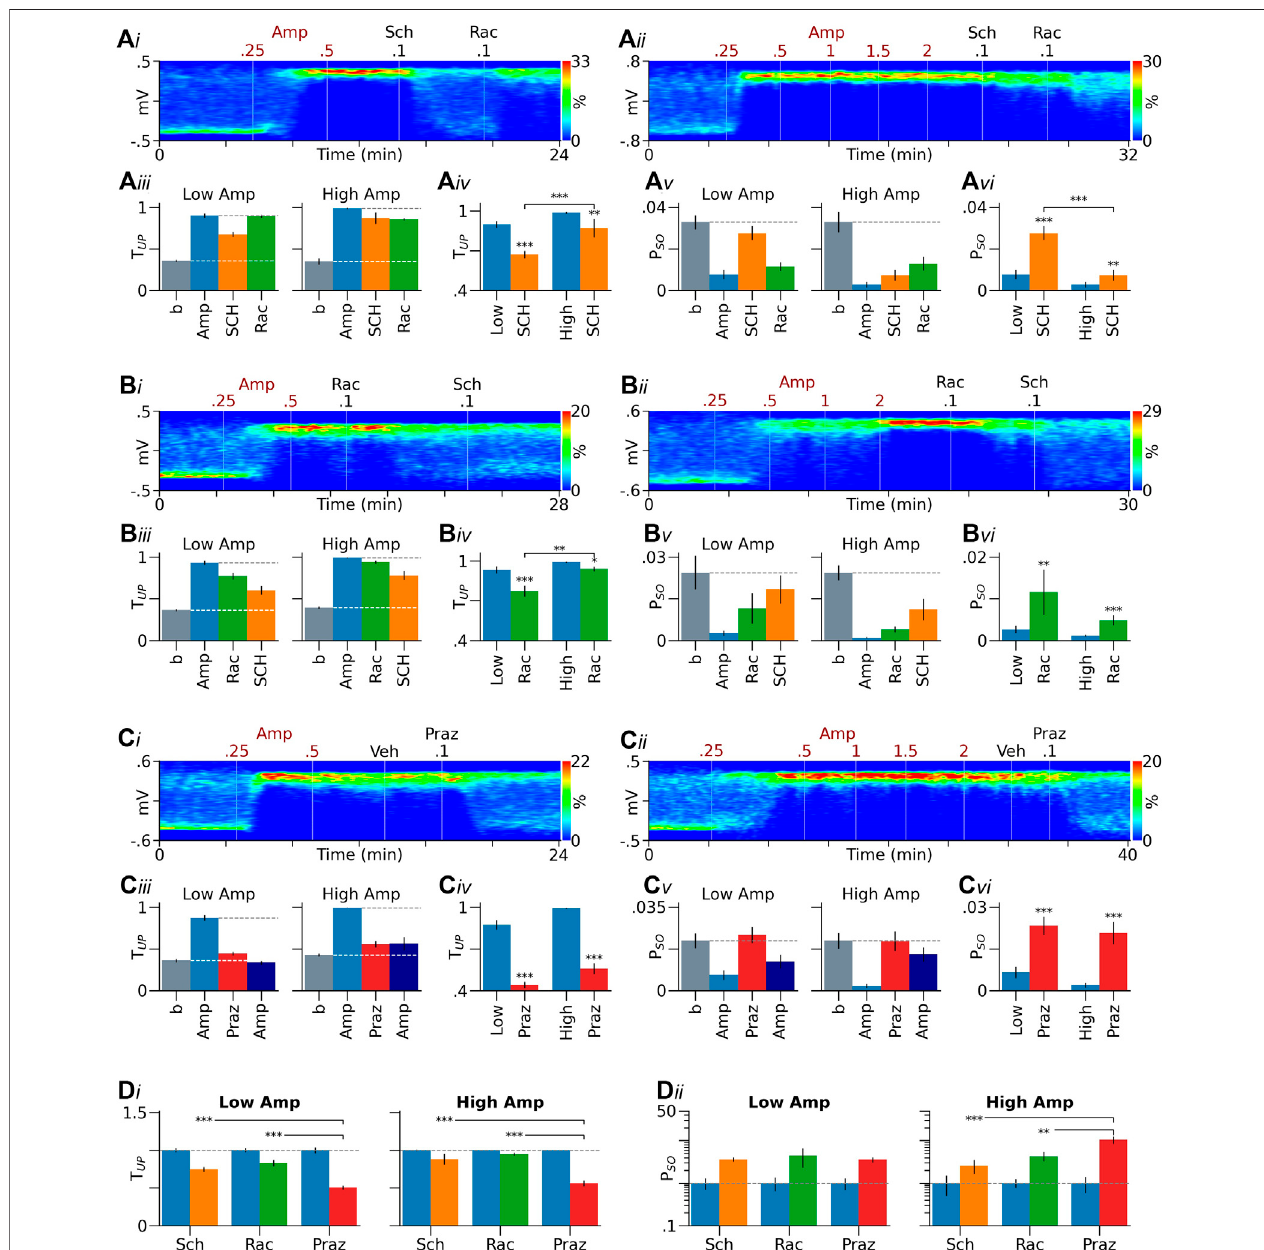
FIGURE3| RoleofDAreceptorsineffectsinducedbylowandhighdosesof D -amphetamine. (Ai – Aii) HeatmapsfromtworepresentativeratsshowingthattheD1- like receptor antagonist SCH23390 (SCH) more effectively reversed the effect induced by a low dose of D -amphetamine (Amp, A1) than that induced by a high dose (Ai-ii) . (Aiii) Summarybargraphsshowingthatinbothlowandhigh-amphetaminegroups,SCH23390partiallyreversedtheincreaseinT UP inducedby D -amphetamine. The D2-like receptor antagonist raclopride (Rac), injected after SCH23390, increased T UP in the low-amphetamine group and produced no further effects in the high-amphetamine group. (Aiv) MIXED analysis using values obtained after D -amphetamine as covariates (blue bars) suggests that SCH23390 ’ s effect is signi fi cantly larger in the low-amphetamine group than in the high-amphetamine group. (Av, Avi) Similar results were obtained with P SO (see Results for more detailed description). (Bi – Bvi) Raclopridewasalsomoreeffective inreversing D -amphetamine ’ seffectinthelow-amphetaminegroupthan inthehigh-amphetaminegroup. SCH23390, given after raclopride, further reversed the effect of D -amphetamine. (Ci – Cvi) Prazosin (Praz), but not its vehicle (Veh), signi fi cantly reversed the effect of D -amphetamine. No signi fi cant differences were found in prazosin ’ s effect between the low and high-amphetamine groups. After prazosin, injections of additional doses of D -amphetamine (2.5 – 4.5 mg/kg)slightlydecreasedT UP andP SO inthelow-amphetaminegroupandproducednofurthereffectsinthehigh-amphetaminegroup. (Di,Dii) Inboththelow andhigh-amphetaminegroups,SCH23390andracloprideweresigni fi cantlylesseffectivethanprazosininreversing D -amphetamine ’ seffectonT UP (Di) .Theywerealso less effective than prazosin in reversing D -amphetamine ’ s effect on P SO in the high, but not low-amphetamine group (Dii) . Data are normalized by the means obtained after D -amphetamine injection (blue bars). * p < 0.05, ** p < 0.01, *** p < 0.001 compared to D -amphetamine (blue bars in Aiv, Avi, Biv, Bvi, Civ, Cvi ), the high amphetamine group (Aiv, Avi, Biv) , or prazosin (Di, Dii) .